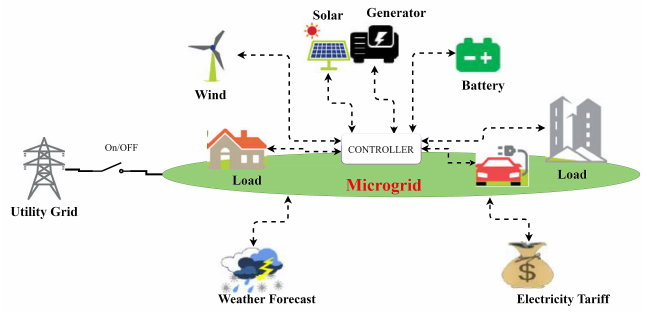
Figure 2. Smart microgrid systems.